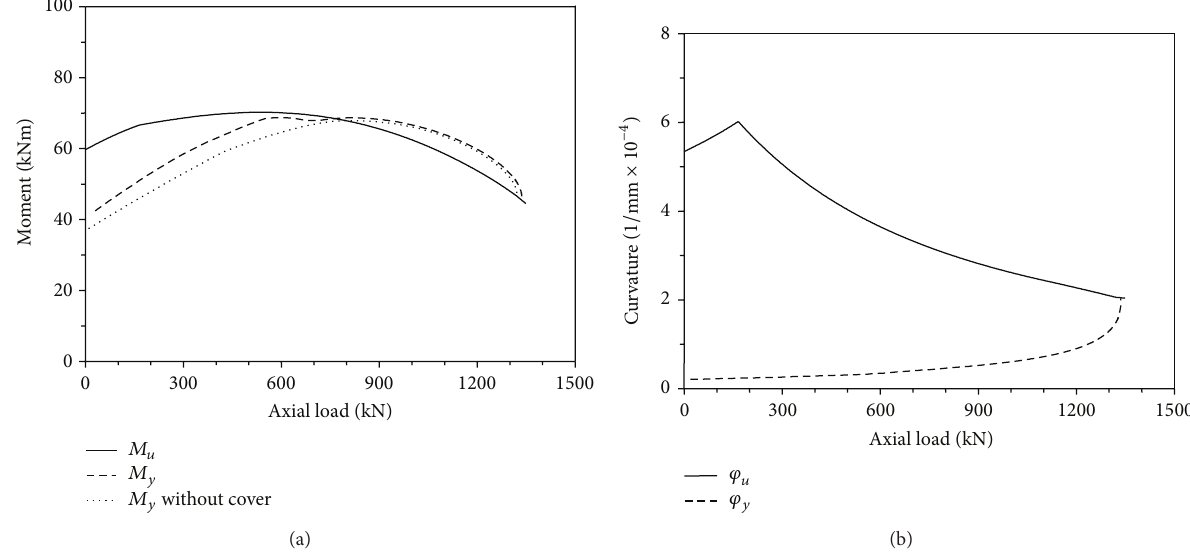
Figure 10: 𝑀 - 𝑁 and 𝜑 - 𝑁 domains at the ultimate state and the first yielding of reinforcement.